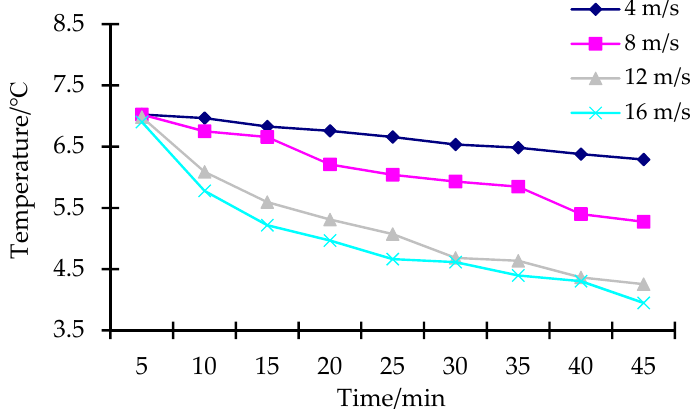
Figure 10. Cooling time with different velocity levels.